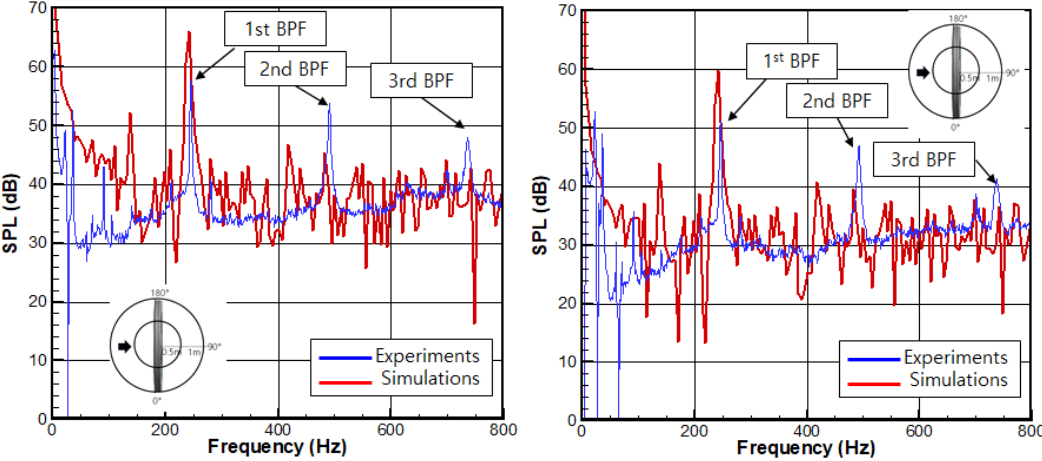
Figure 11. Frequency histories of SPL at 0.5 m ( left ) and 1m ( right ), θ = 90° in the downstream. Figure 12. SPL visualization of the fan noise source on the suction ( left ) and pressure ( right ) sides between 242.7 Hz and 246.6 Hz band range .